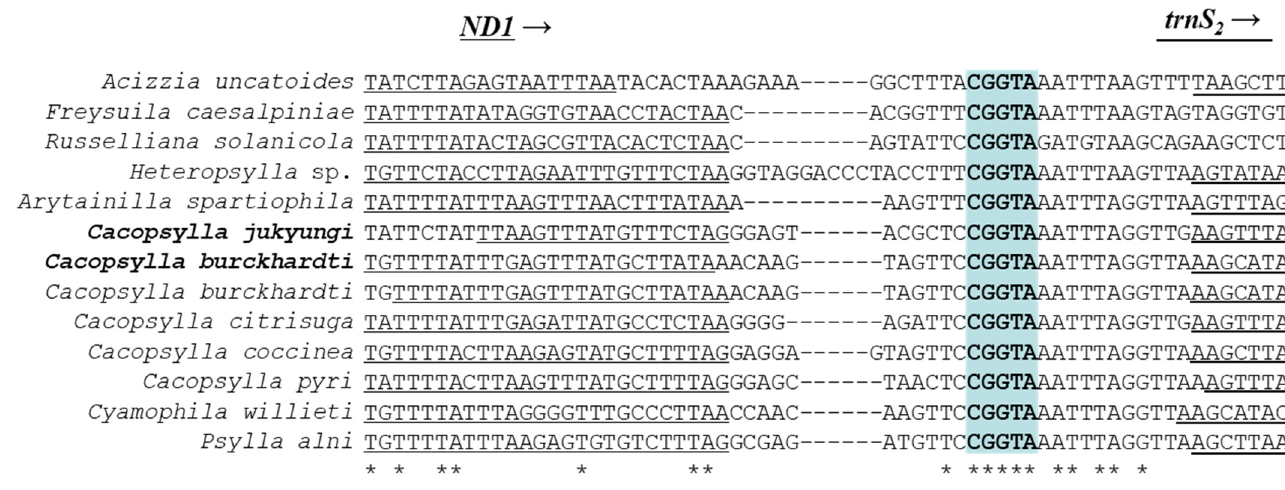
Figure 1. Alignment of the internal spacer located between trnS2 and ND1 of 13 Psyllidae species, including Cacopsylla jukyungi and C. burckhardti , which were considered in this study. The shaded nucleotides indicate a conserved stretch of penta-nucleotides (CGGTA). The underlined nucleotides indicate the adjacent partial sequences of trnS2 and ND1 . The arrows indicate the transcriptional direction. *, consensus sequences.